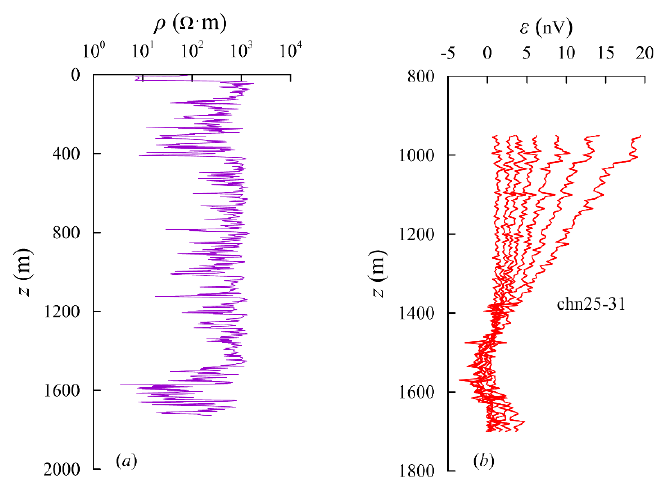
Figure 10. The logging curves. ( a ) The resistivity logging curves; ( b ) The TEM logging curves of 25 – 31 channels.